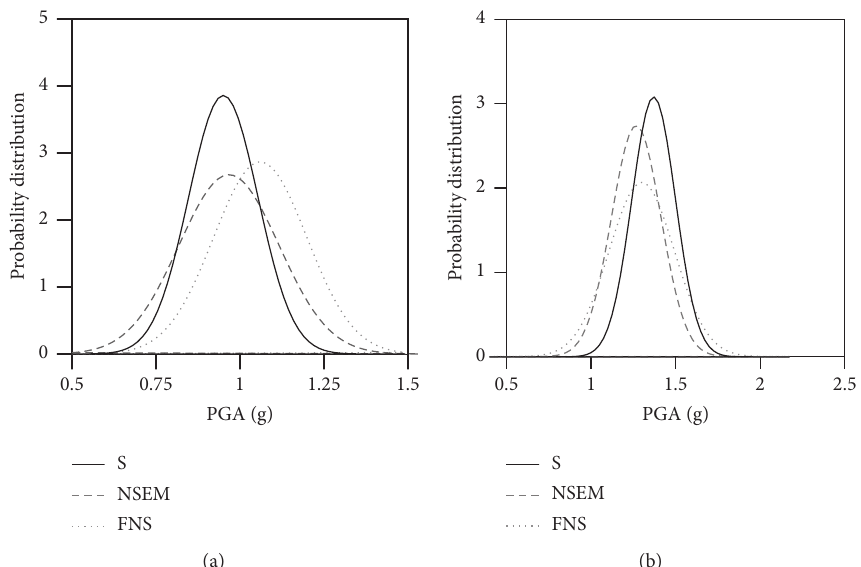
Figure 11: Probability density of the collapse PGA of M1 and M2 models. (a) M1 model collapse PGA distribution. (b) M4 model collapse PGA distribution.